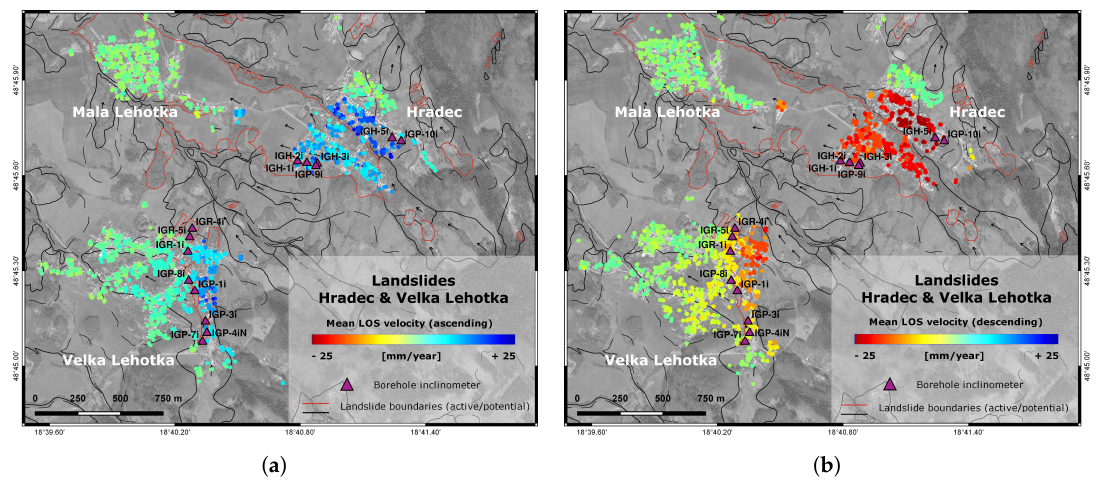
Figure 8. Hradec and Velka Lehotka landslides as observed by Sentinel-1 MT-InSAR: mean line-of-sight (LOS) deformation velocity maps from ( a ) ascending and ( b ) descending track. Purple triangles represent borehole inclinometry monitoring network. Basemap: Google, 2017